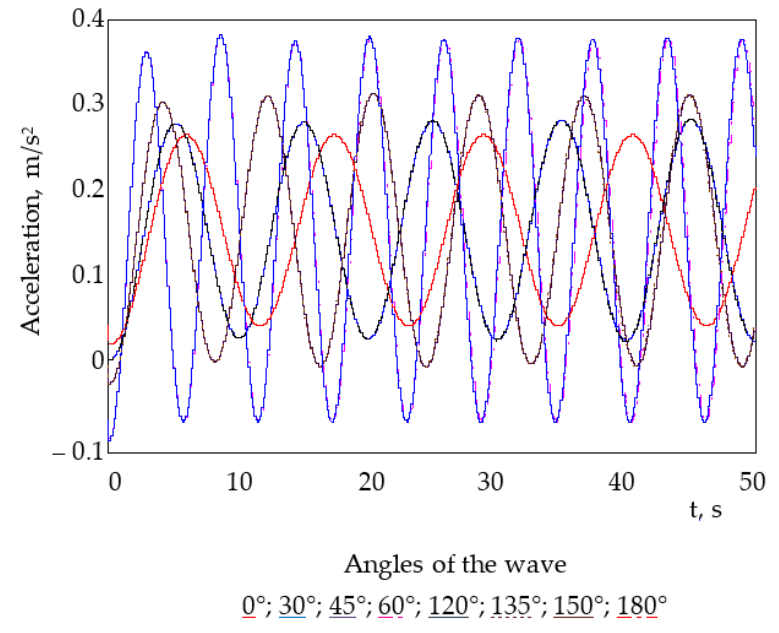
Figure 4. Accelerations acting on the load-bearing structure of the flat wagon when transported on a railway ferry.